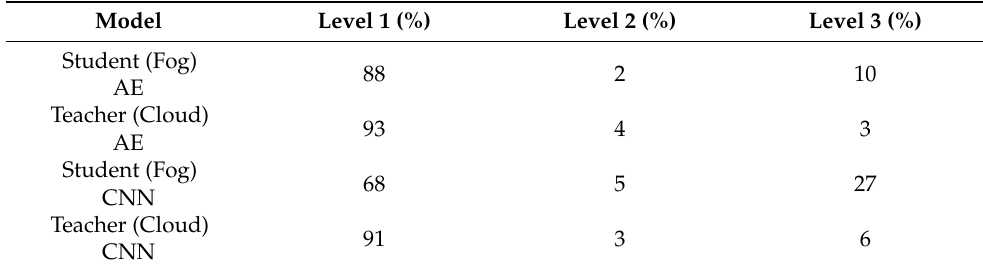
Table 6. Alarm-level test result percentages for the casting dataset.